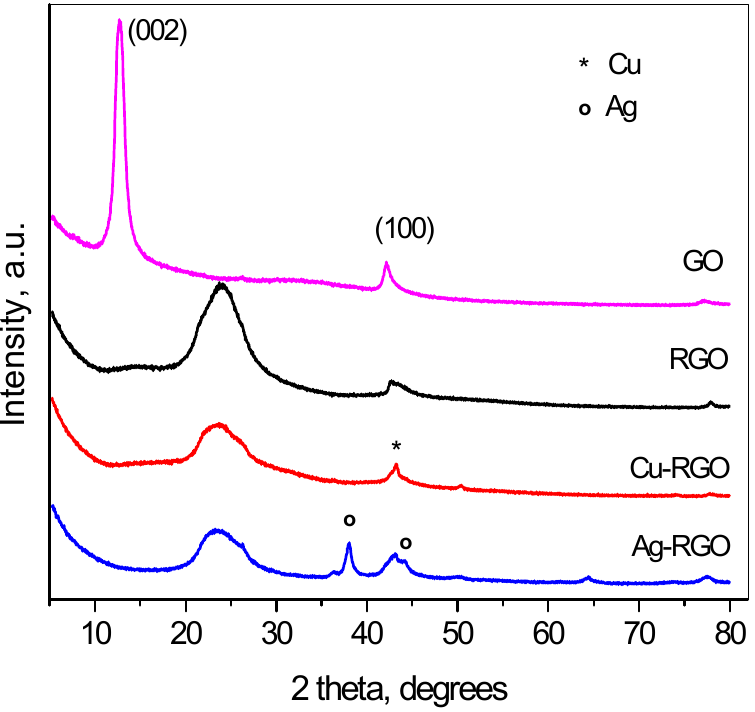
Figure 1. Powder X-ray diffraction patterns of GO, RGO and the composites Cu–RGO and Ag–RGO. The symbols denote: *—metallic copper, ◦ —metallic silver.